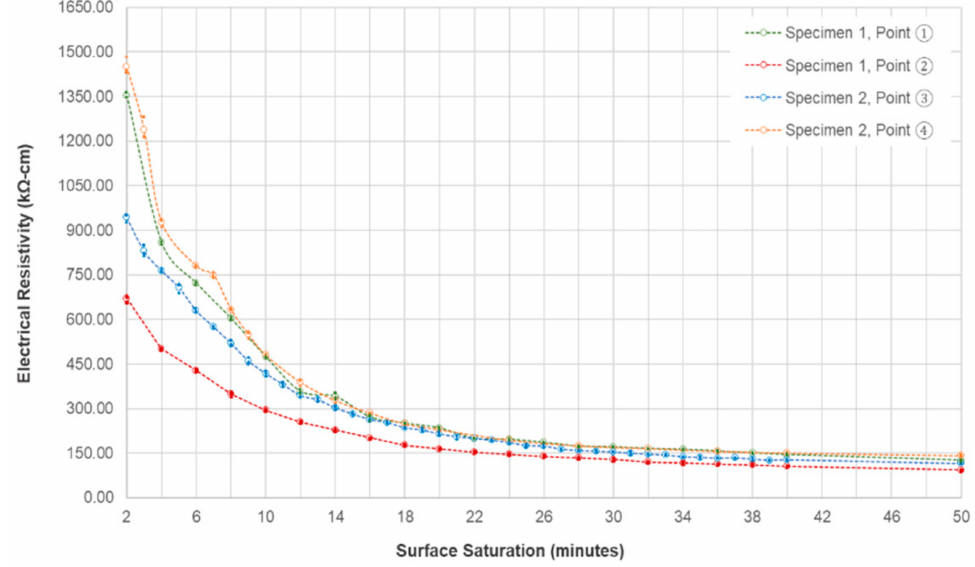
Figure 11. E ff ect of instantaneous saturation to the electrical resistivity measured with respect to